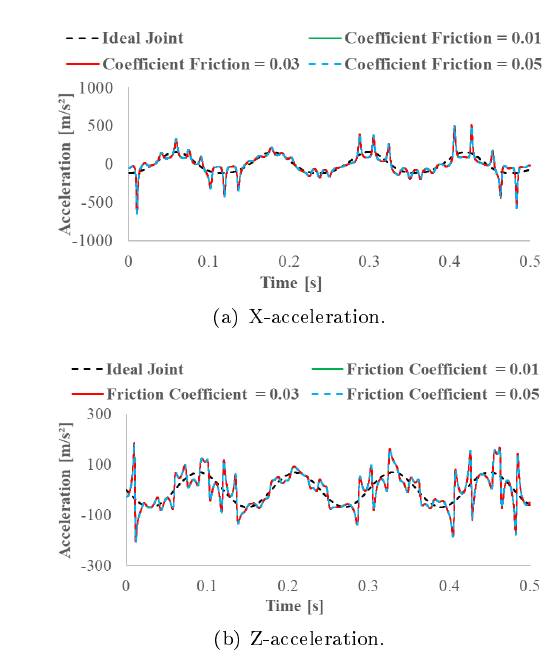
Fig. 7: Velocity of the 1 st connecting rod.